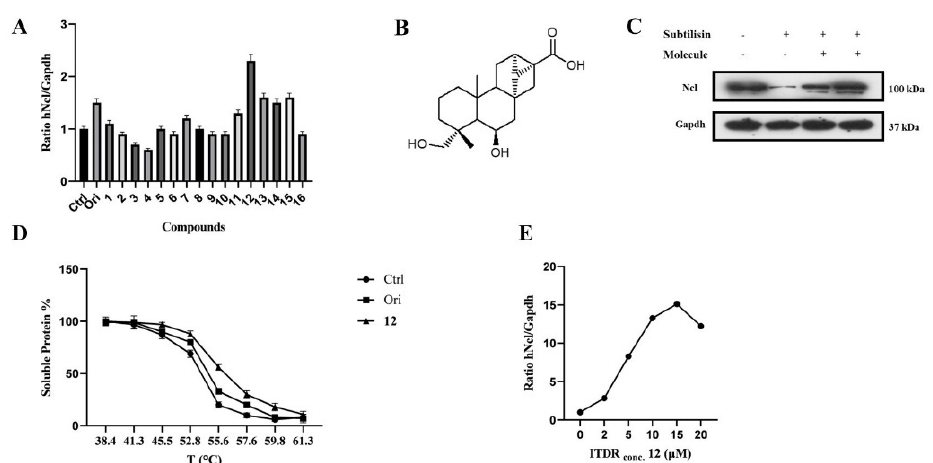
Figure 1. 6,19 − dihydroxy − ent − trachiloban − 17 − oic acid (compound 12 ) interacts effectively with hNcl. ( A ) Results of the CETSA − based screening of a small library of diterpenes. ( B ) Chemical structure of compound 12 . ( C ) DARTS experiment results. ( D ) Thermal denaturation curve of hNcl in HeLa cell lines untreated or incubated with oridonin or compound 12 . ( E ) CETSA-based measurement of the EC 50 of compound 12 in HeLa cells.